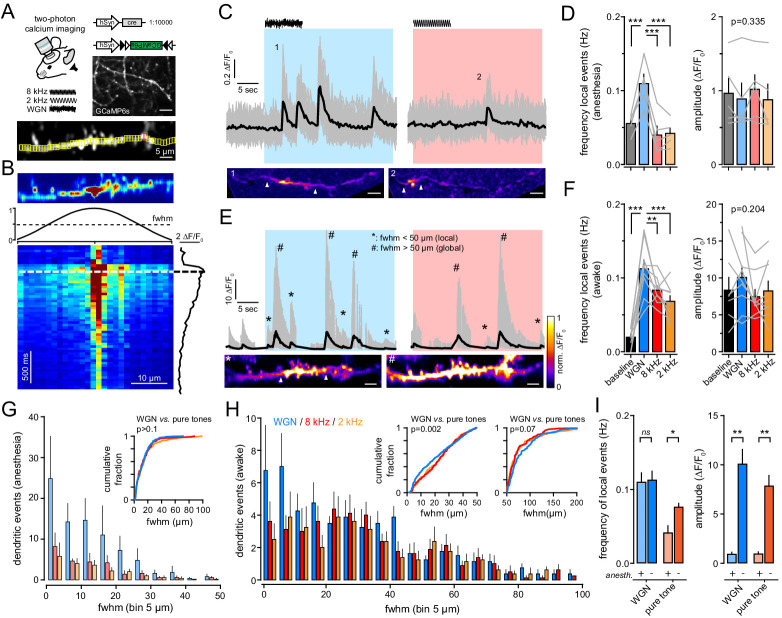
Gaussian auditory stimulation evokes more local dendritic events than pure frequency tones in anesthesia and awake.(A) Top, experimental strategy resulting in the sparse expression of GCaMP6s. Scale bar, 10 µm. Ca2+ events in individual dendrites were imaged in L1 upon auditory stimulation in awake or anesthetized mice. Bottom, example of GCaMP6s fluorescence standard deviation image with ROIs in yellow. Red ROIs overlapped with another dendrite and were excluded from the analysis. (B) The spread of Ca2+ events was quantified by calculating the full-width at half-max (fwhm, dashed line) of the normalized Gaussian fit at the time when the averaged ΔF/F0 was maximal. (C) Top, example of multiple Ca2+ transients (ΔF/F0) recorded in a single dendrite in anesthetized mouse, during baseline and upon WGN (blue) and 8 kHz (red). Gray lines, ΔF/F0 measured from small ROIs (all ROIs superimposed). Black line, mean ΔF/F0 averaged over all ROIs, respectively. Bottom, examples of local dendritic Ca2+ events upon WGN (1) and 8 kHz (2). Scale bar, 5 µm. (D) The frequency (left) and amplitude (right) of all Ca2+ events observed during baseline and upon auditory stimulations was averaged over five anesthetized mice. Gray lines represent individual mice. (E) Top, same representation as (C) but in awake mouse. Bottom, example of local (*) and global (#) dendritic Ca2+ events. Scale bar, 5 µm. (F) Same presentation as in (D) but for local events from nine awake mice. Gray lines represent individual mice. (G, H) Distribution histogram of dendritic events fwhm upon WGN (blue), 8 kHz (red) and 2 kHz (orange) tone presentation, from anesthetized (G) and awake (H) mice. Inset, cumulative probability histograms of auditory-evoked events fwhm. (I) Dendritic events evoked by WGN and pure tones (8 kHz and 2 kHz tones pooled together) in anesthetized (+) and awake (-) mice. *, p<0.05; **, p<0.01; ***, p<0.001.Figure 2—source data 1.Frequency of dendritic calcium events.